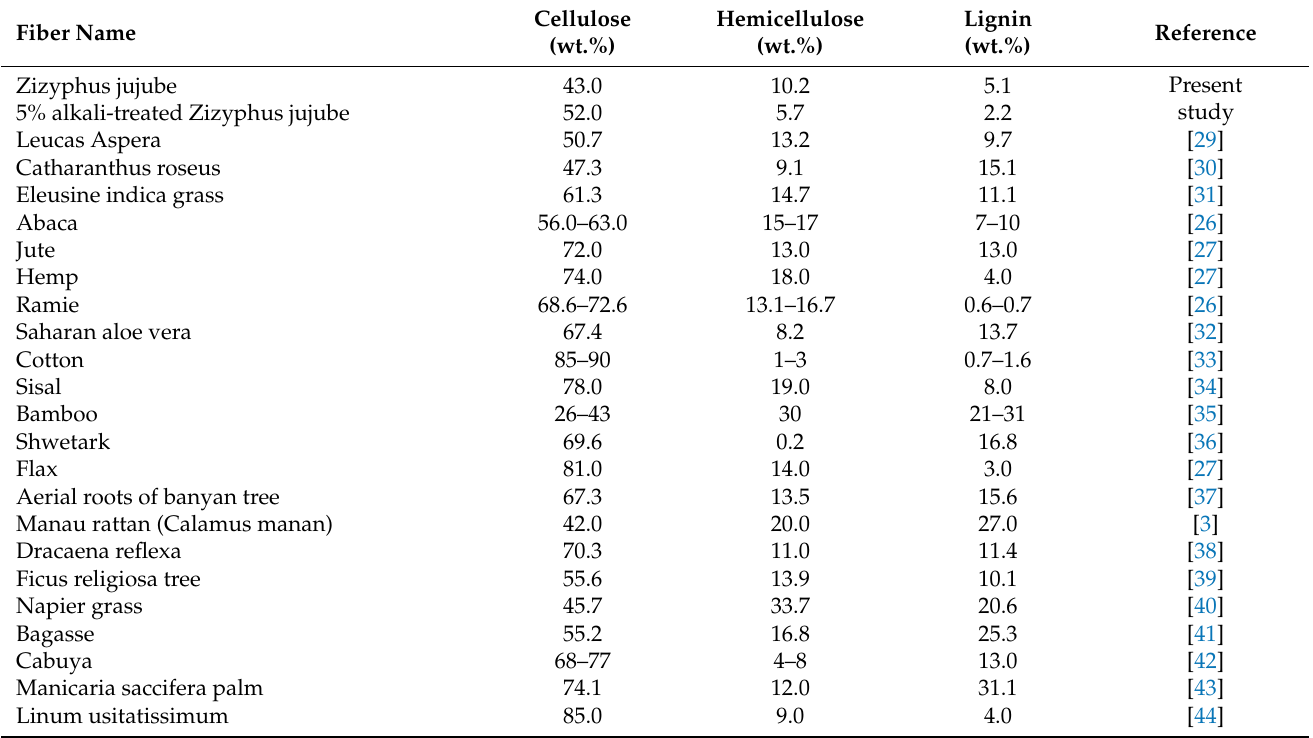
Table 1. Comparison of chemical composition of Ziziphus jujuba fiber before and after alkali treatment with other natural